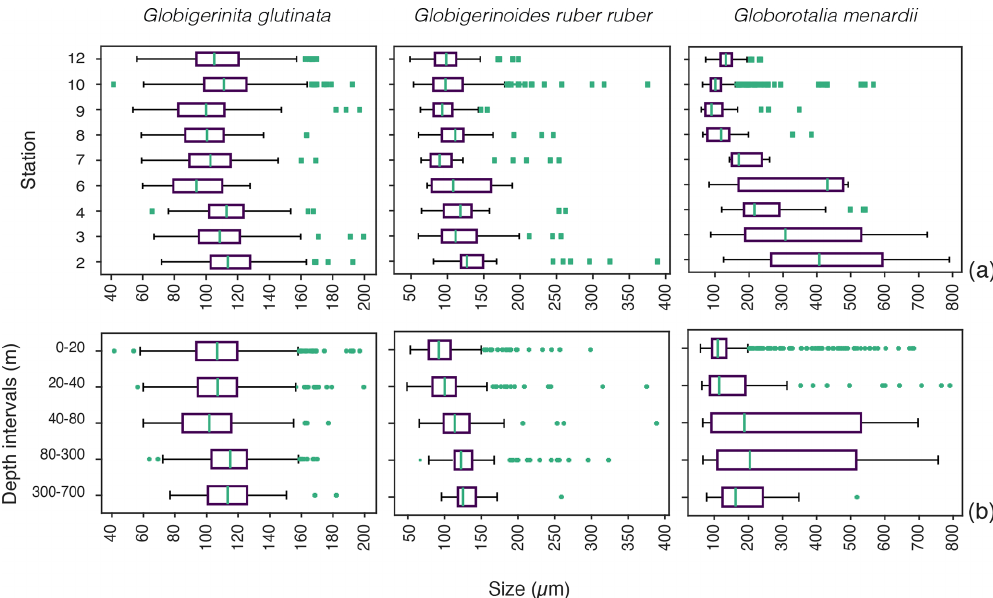
Figure 4. Size distribution of living specimens for the three studied species (a) across the different stations and (b) across the depth profile from the surface (0–20m depth) to the mesopelagic environment (300–700m depth). Green dots indicate outliers. The boxes extend to the interquartile range (IQR), and the whiskers indicate 1.5 · IQR. The green lines in the boxes indicate the median.